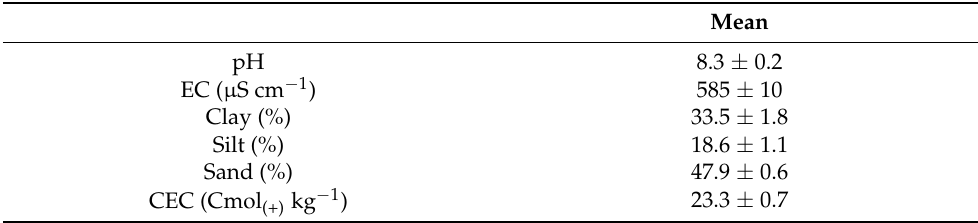
Table 1. Chemical properties of the individual samples collected at the site under investigation. Values are reported as mean ( n = 3) ± SD.